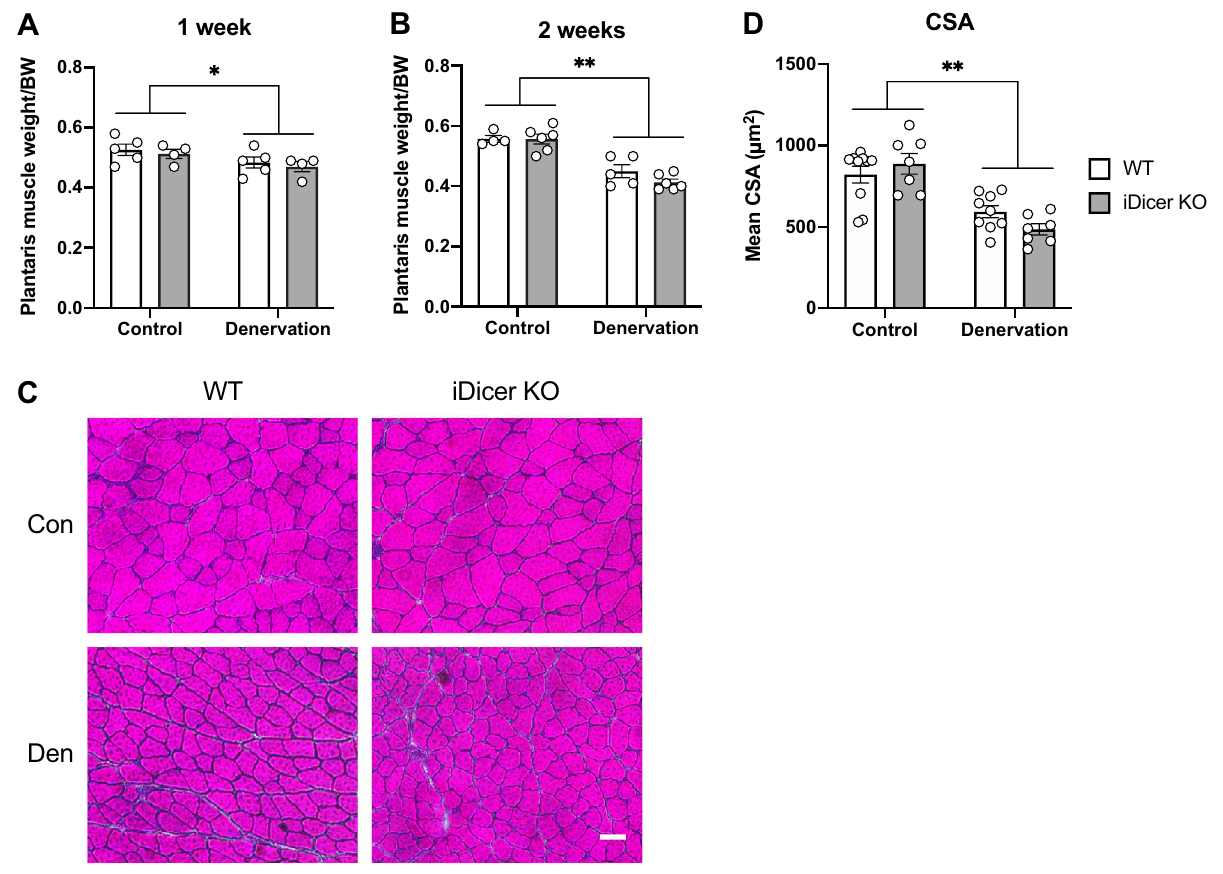
Figure 5. Denervation-induced atrophy of fast-twitch plantaris muscles in the iDicer knockout mice. ( A , B ) Changes of plantaris muscle weight after 1 week ( A ) and 2 weeks ( B ) of denervation. The plantaris muscle weight was significantly decreased in both genotypes at 1 week (Denervation, P < 0.05) and 2 weeks after denervation (Denervation, P < 0.01). Deletion of Dicer in adult muscles did not also affect denervation-induced plantaris muscle atrophy (n = 4–6). ( C ) Representative images of H&E staining in control and denervated plantaris muscles of WT and iDicer KO mice. ( D ) Mean fiber CSAs of denervated plantaris muscles did not alter between WT and iDicer KO mice (Denervation, P < 0.01) (n = 7–10). *P < 0.05, **P < 0.01. Scale bar = 50